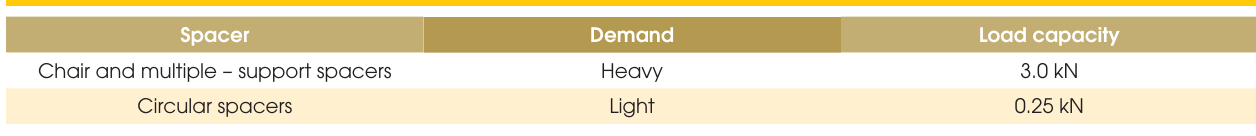
Table 2 – Parameters for the maximum load value applied in